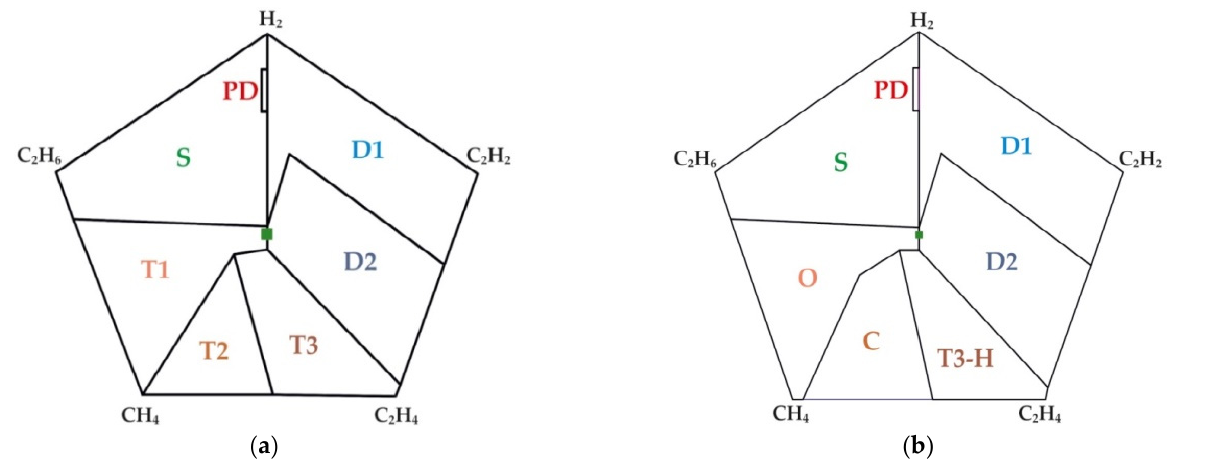
Figure 2. Representation of fault areas in the Duval Pentagon: ( a ) DPg-1; ( b ) DPg-2.